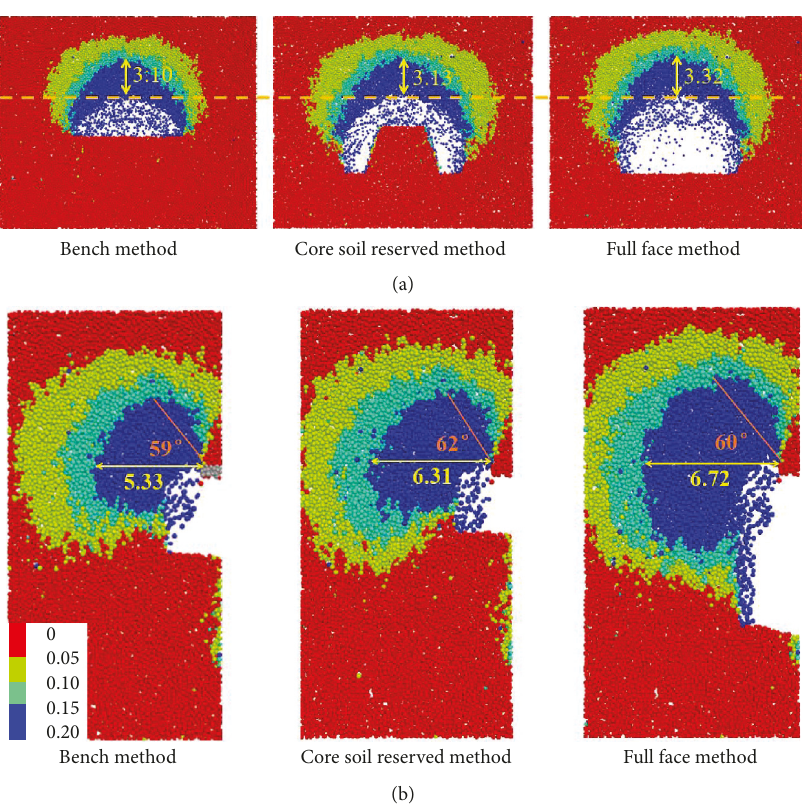
Figure 11: Displacement distribution of the surrounding rock under different excavation methods: (a) front view; (b) side view. Unit: m.